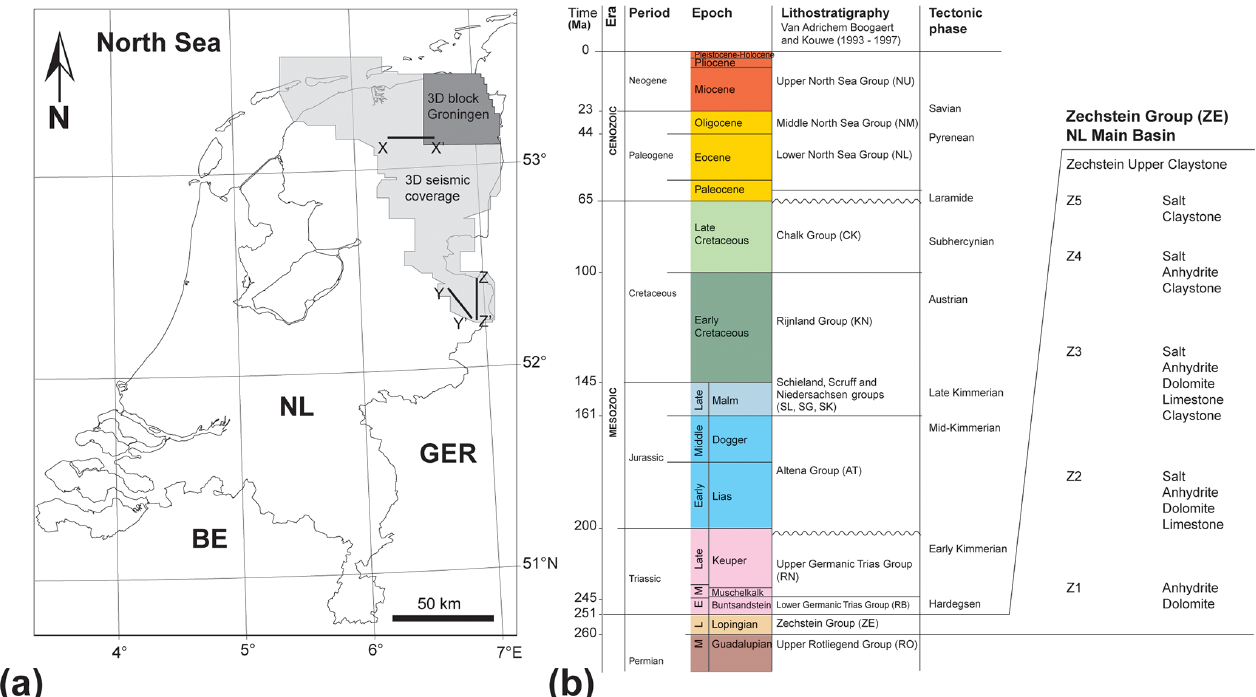
Figure 2. (a) Study area in the NE of the Netherlands and 3D seismic coverage. Three-dimensional block Groningen used for quality control. Lines X – X (cid:48) and Y – Y (cid:48) shown in Fig. 3. BE: Belgium; GER: Germany; NL: The Netherlands. (b) Stratigraphy of the study area (after Van Adrichem Boogaert and Kouwe, 1993). Detailed lithostratigraphic subdivision of the Zechstein Group on the right. Stratigraphic abbreviations used in following